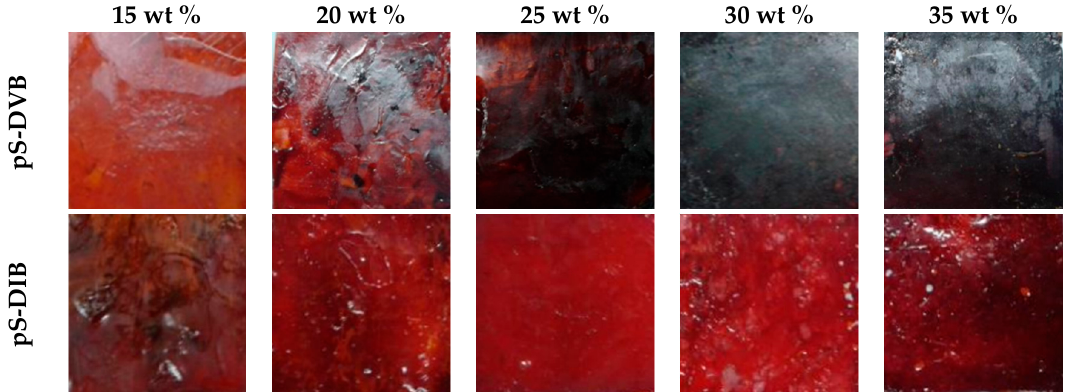
Figure 2. Illustrations of pS-DVB- ( above ) and pS-DIB-films ( below ) obtained by hot press treatment with varying incorporated monomer content.